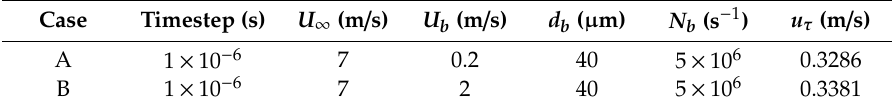
Table 1. Flow field and bubble properties.